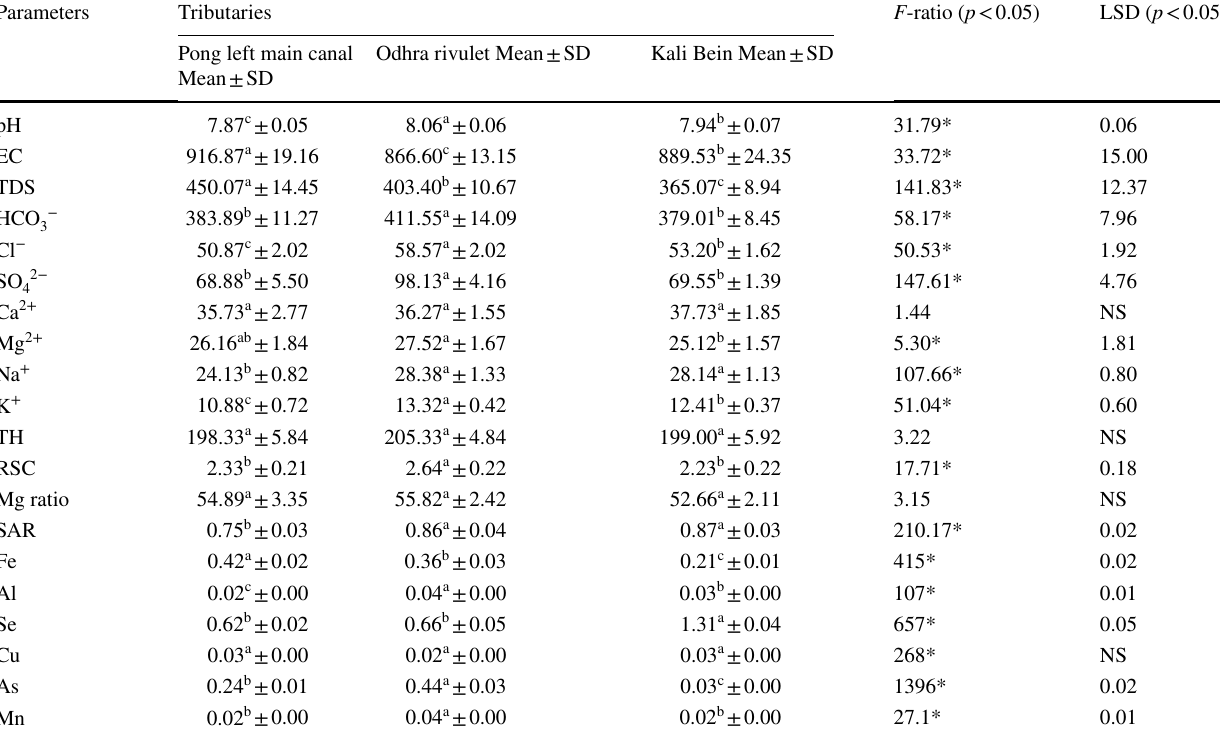
Table 3 One way- ANOVA and Tukey’s multiple comparison tests for water quality parameters of samples collected from the proximity of tribu- taries of Beas River, India for the post-monsoon period (October, 2019)